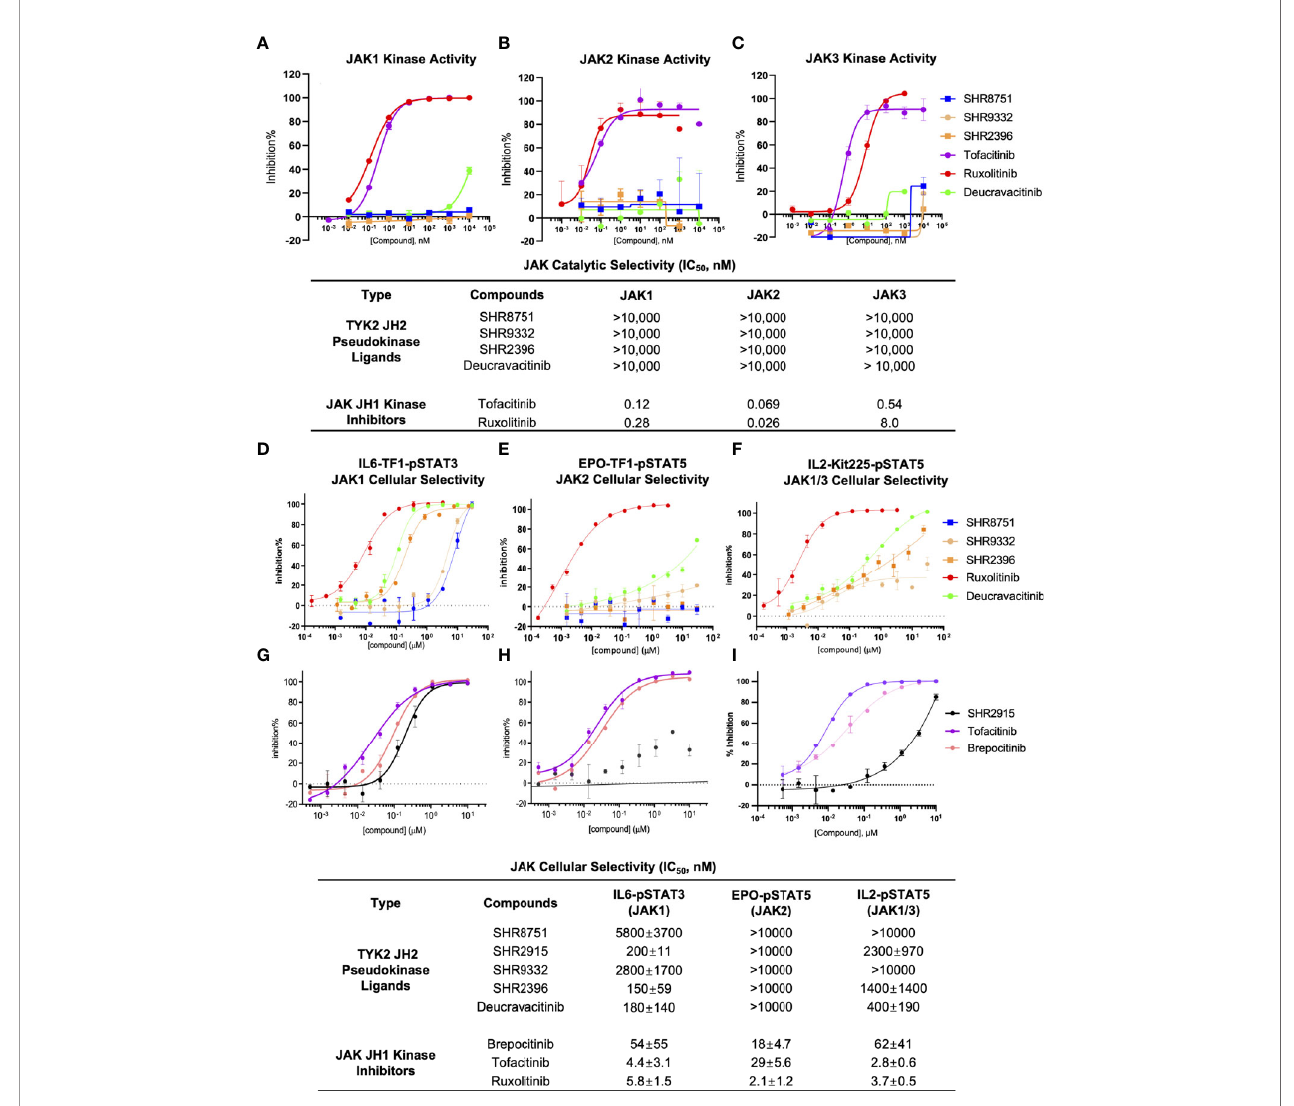
FIGURE 7 | TYK2 pseudokinase ligands showed limited potency in affecting JAK1-3 functional activities. (A – C) Effect of TYK2 JH2 ligands SHR8751, 9332, 2396, Deucravacitinib and JAK inhibitors Tofacitinib and Ruxolitinib in suppressing JAK1 (A) , JAK2 (B) and JAK3 (C) kinase activities assessed by Z ’ LYTE kinase bio- chemical assay. Serially diluted test compounds were added into a kinase reaction buffer that contains JAK kinases (JAK1, JAK2 or JAK3, respectively) and Z9- LYTE ™ Tyr6 Peptide for measurement of JAK kinase-induced peptide phosphorylation. The curve fi t was generated, and statistical analysis was performed using GraphPad Prism. IC 50 values were derived by non-linear regression analysis and de fi ned as the compound concentration at which the response level was reduced to half of its maximum relative to a DMSO control; (D, G) Effect of TYK2 JH2 ligands and TYK2/JAK kinase inhibitors SHR8751, 9332, 2396, Deucravacitinib and Ruxolitinib (D) and SHR2915, PF841 and Tofacitinib (G) on JAK1-dependent IL6-induced phosphorylation of STAT3 (Tyr705) in TF1 cells. TF1 cells were treated by serially diluted compounds (30 m M, 1:3) for 1 hour and stimulated by recombinant human IL6 for 20 mins. Phosphorylation of STAT3 (Tyr705) was measured in cell lysates using AlphaLISA assay; (E, H) Effect of TYK2 JH2 ligands and TYK2/JAK kinase inhibitors SHR8751, 9332, 2396, Deucravacitinib and Ruxolitinib (E) and SHR2915, PF841 and Tofacitinib (H) on JAK2-dependent EPO-induced phosphorylation of STAT5 (Tyr694/699) in TF1 cells. TF1 cells were treated by serially diluted compounds (30 m M, 1:3) for 1 hour and stimulated by recombinant human EPO for 20 mins. Phosphorylation of STAT5 (Tyr694/699) was measured in cell lysates using AlphaLISA assay; (F, I) Effect of TYK2 JH2 ligands and TYK2/JAK kinase inhibitors SHR8751, 9332, 2396, Deucravacitinib and Ruxolitinib (F) and SHR2915, PF841 and Tofacitinib (I) , on JAK1/3-dependent IL2-induced phosphorylation of STAT5 (Tyr694/699) in Kit225 cells. Kit225 cells were treated by serially diluted compounds (30 m M, 1:3) for 1 hour and stimulated by recombinant human IL2 for 20 mins. Phosphorylation of STAT5 (Tyr694/699) was measured in cell lysates using AlphaLISA assay. For each assay, inhibition data were calculated by comparison to vehicle control wells for 0% inhibition and non-stimulated control wells for 100% inhibition. Dose response curves were generated to determine the IC 50 values as derived by non-linear regression analysis using GraphPad Prism. Con fi rmatory studies were performed for the compounds. The fi gures are representative of three independent experiments with duplicates performed for each experiment unless stated otherwise. The average IC 50 values and standard deviations of each compound from three independent experiments are calculated and summarized in the